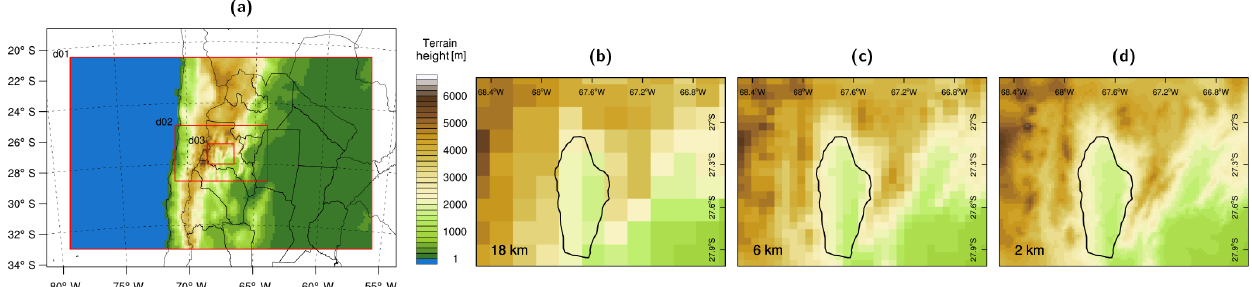
Figure 7. WRF model domain configuration. The colors indicate the model terrain height. Three two-way nested domains enclosing the Fiambalá Basin with horizontal resolutions are 18, 6, and 2km, from the parent to the innermost domain, respectively (a) . Terrain height around the Fiambalá Basin for the 18km (b) , 6km (c) , and 2km (d) domains. The Fiambalá Basin is defined by the outlined region (black line). Topography data from the US Geological Survey (USGS).